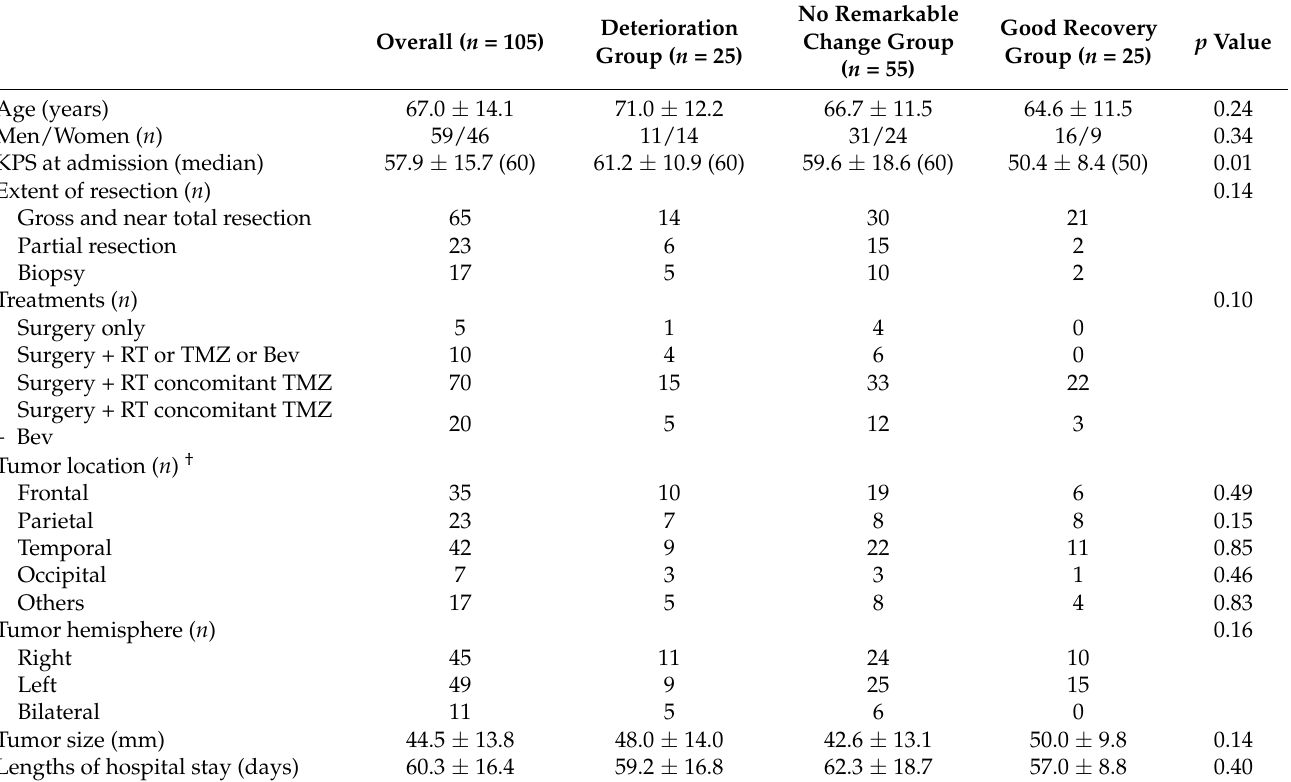
Table 1. Patient’s clinical and tumor characteristics.